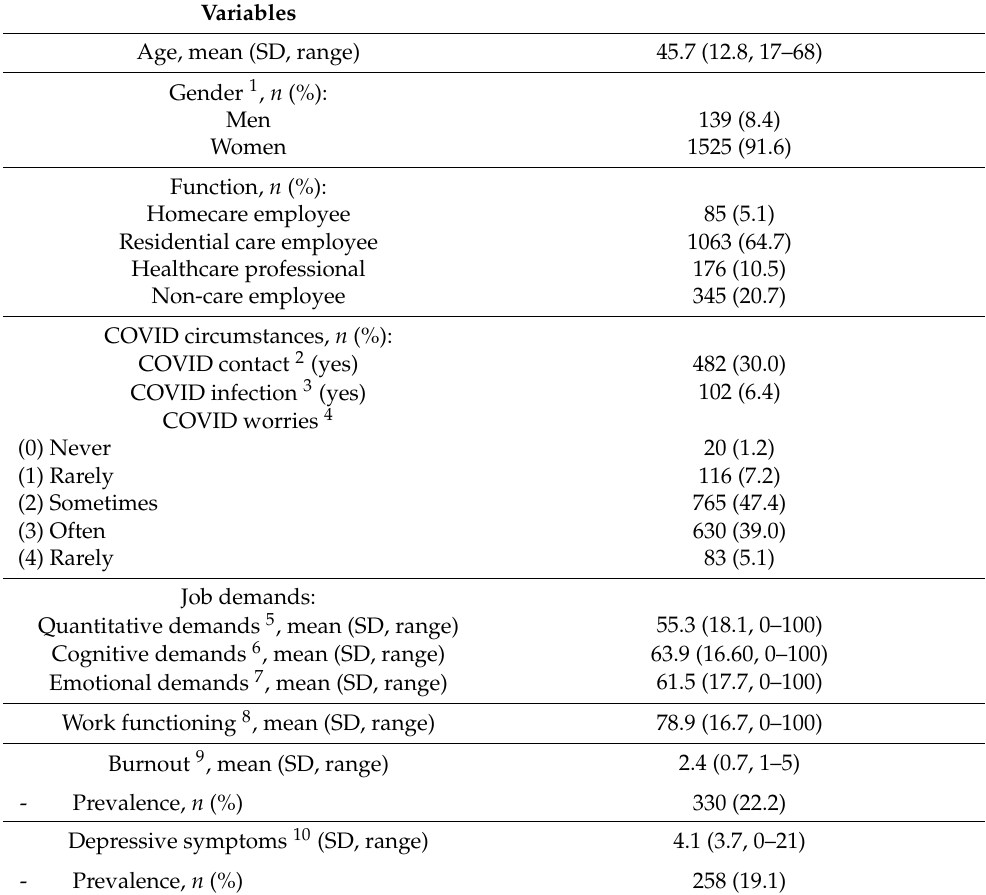
Table 1. Descriptive characteristics of the participants ( n = 1669 nursing home